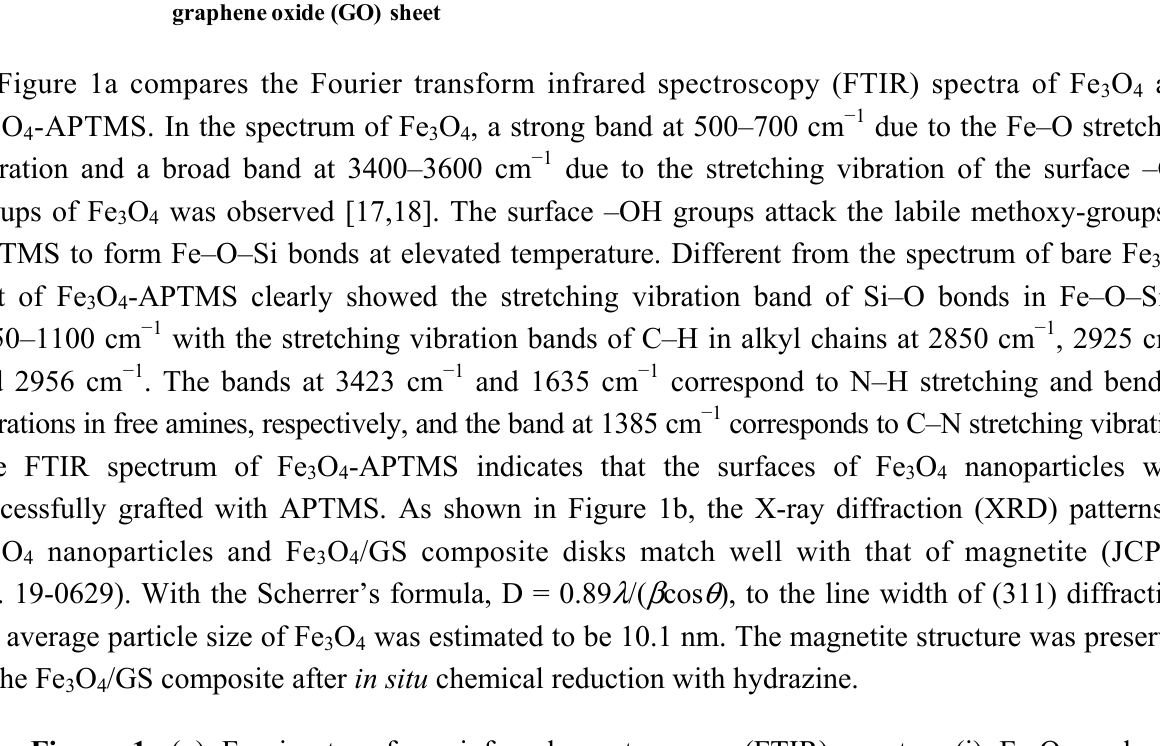
O and 3 4 O and (ii) Fe O 3 4 3 4